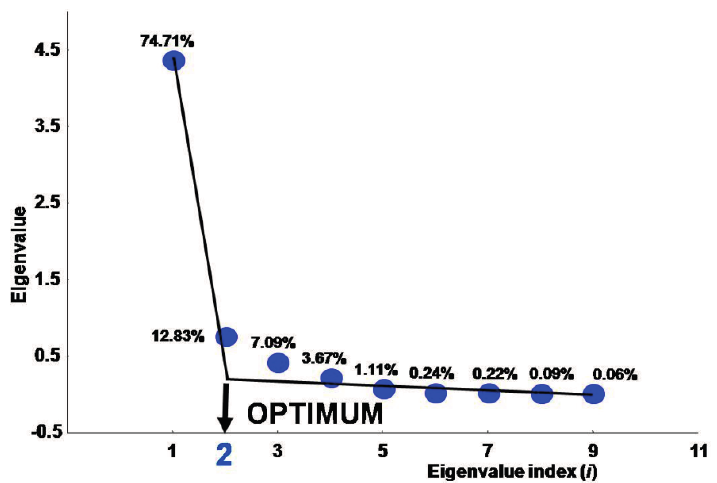
Figure 6. Scree-plot obtained for the reflectance data concerning the 76 locations selected in the El-Fayoum Egyptian region. The method of the tangents gives two structural eigenvalues. The percentage of variance in data explained by each eigenvalue is given.